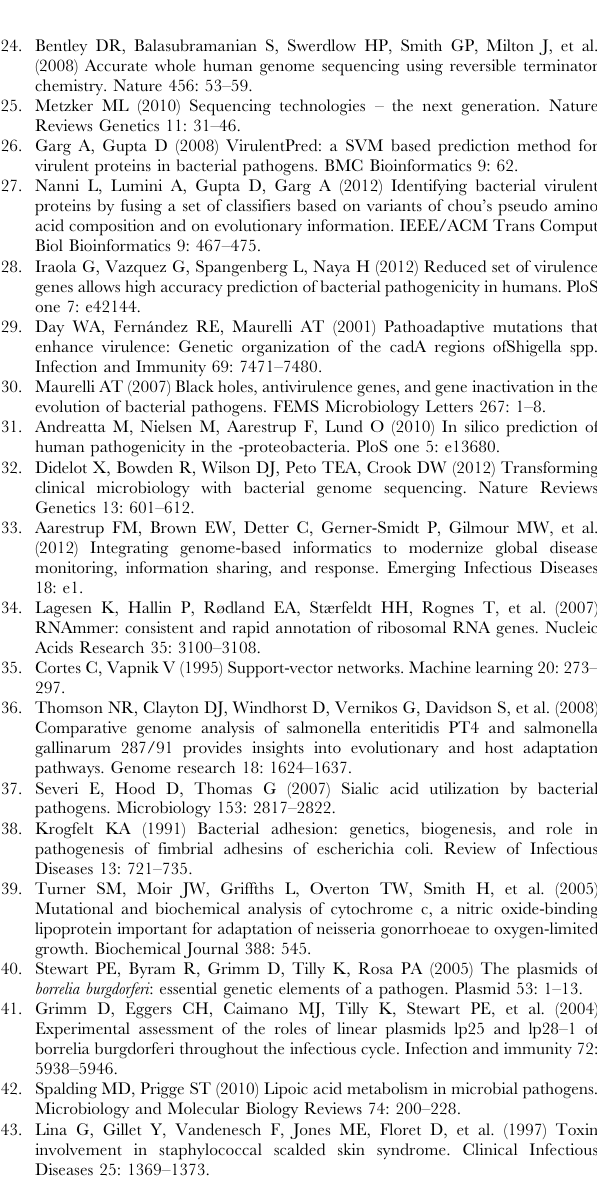
Table S1 Training and Test organisms. xlsx file containing the list of organisms in the training and test-set and a table showing the phyla of the organisms in the training-set used to build the COMPL model. Table S2 Extra Escherichia Coli Strains. xlsx file contain- ing the training-sets used for building ecoli_boost and enterobac_boost models, including the list of extra E. coli strains and a summary of